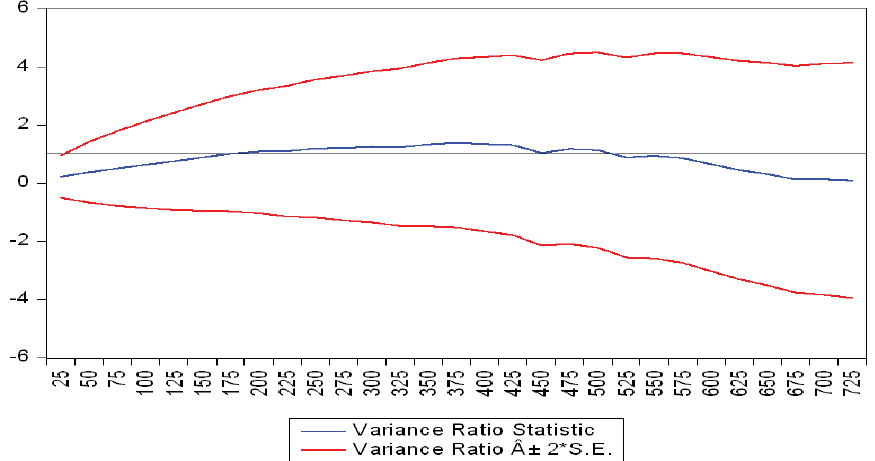
Fig. 2. Graphical illustration of the efficiency of the NSE 20 share index (weekly data over the test periods: January 2001 to January 2015)